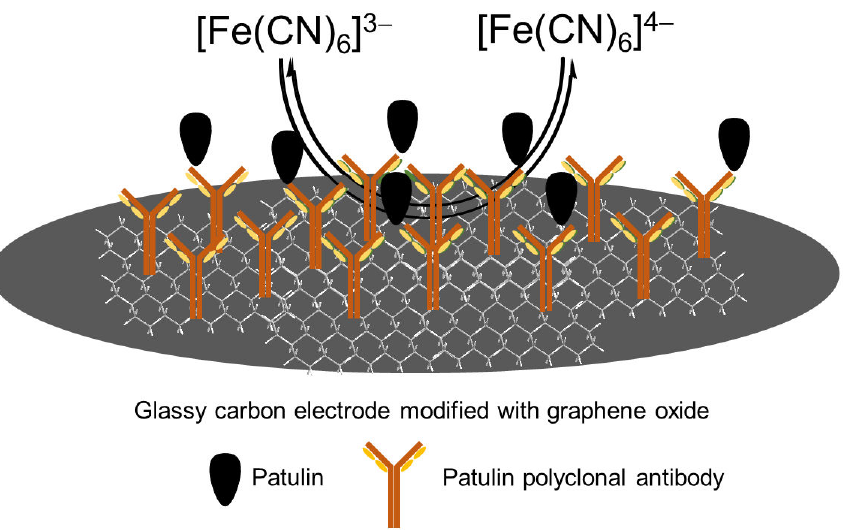
Figure 3. Schematic representation of electrochemical immunosensor for PAT detection in apple juice